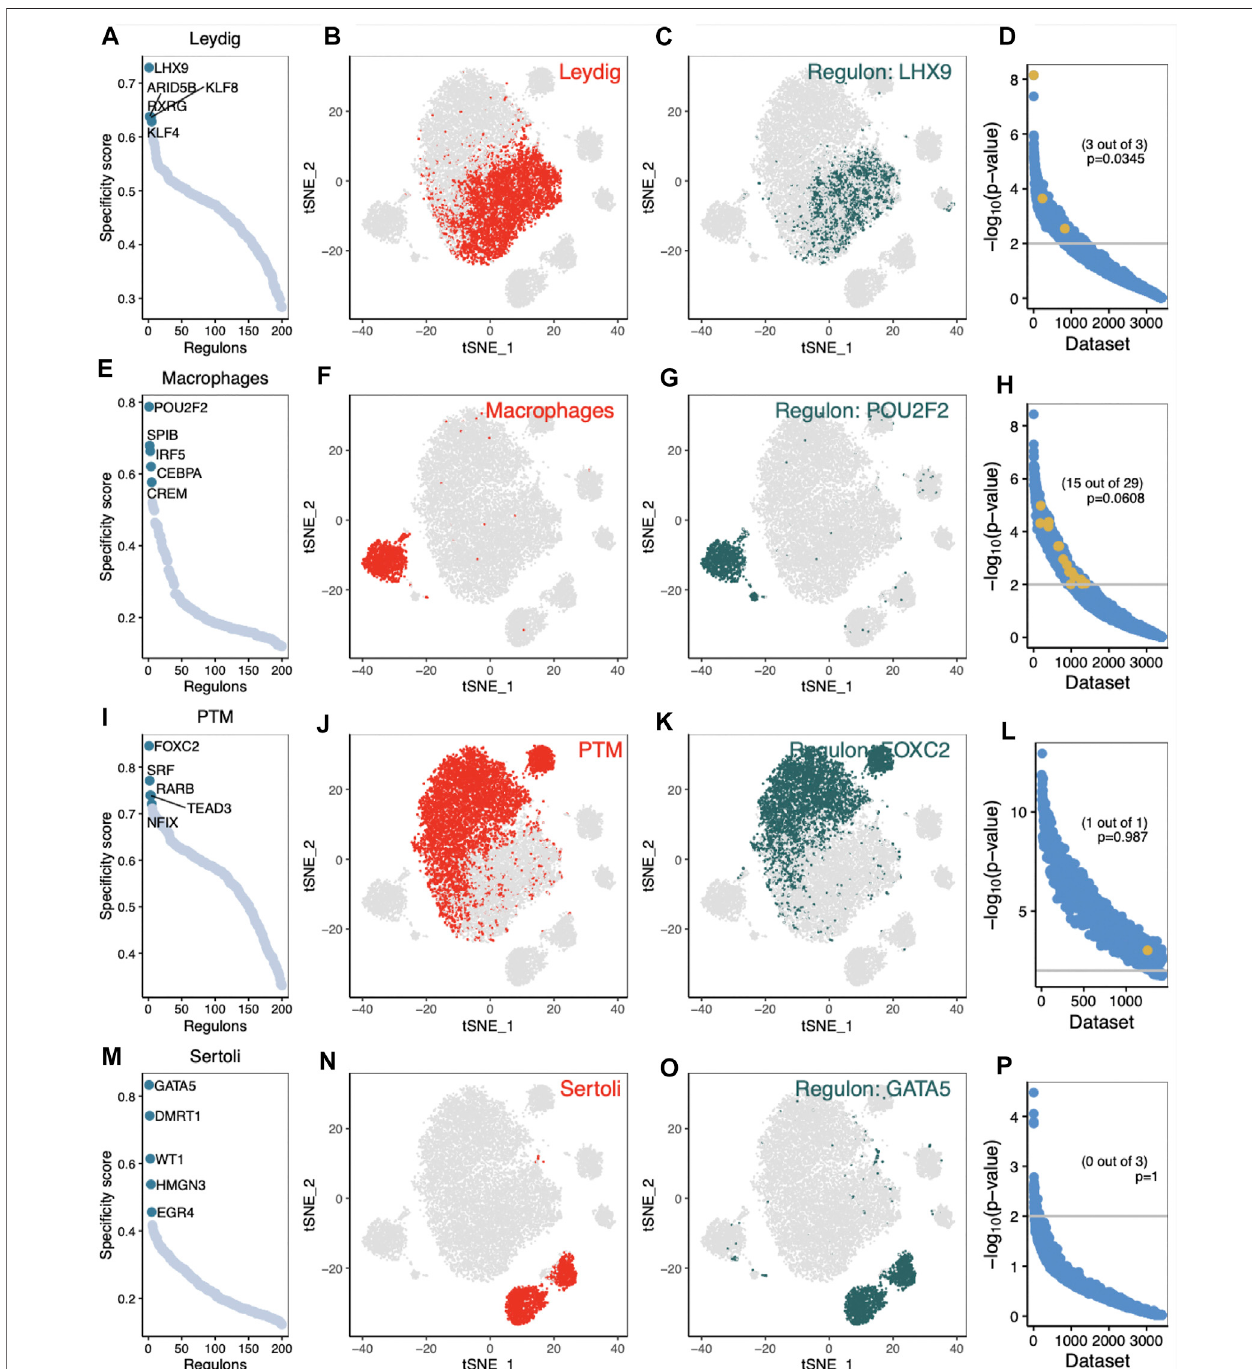
FIGURE 4 | Analysis ofcell type-speci fi c regulation in testis of idiopathic non-obstructive azoospermia (iNOA) patients. (A – D) Leydig cells (LCs). (A) The regulation of testicular cells was ranked according to the regulation speci fi city score. (B) LCs are marked by red dots on the t-distributed random neighbour embedding (t-SNE) diagram. (C) The expression values of the genes with the highest regulatory activity score are displayed in the t-SNE diagram. (D) Search-Based Exploration of Expression (SEEK) analysis was used to determine the co-expression of the highest regulatory genes in different Gene Expression Omnibus (GEO) data sets. The x -axis represents the different data sets, and the y -axis represents the co-expression signi fi cance of the target gene in each data set. Data sets with a signi fi cant correlation ( p < 0.05) are highlighted with yellow dots. (E – H) The same as (A – D) , but for testicular macrophages. (I – L) The same as (A – D) , but for peritubular myoid (PTM) cells. (M – P) The same as (A – D) , but for Sertoli cells.